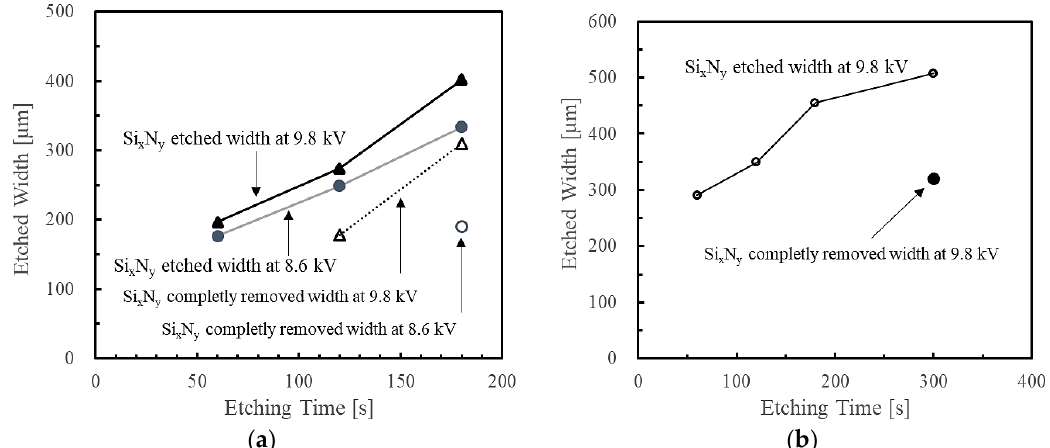
Figure 6. Widths of electrode grooves formed with ( a ) Ar/CF 4 = 700:300 sccm and ( b ) He/CF 4 = 700:300 sccm.